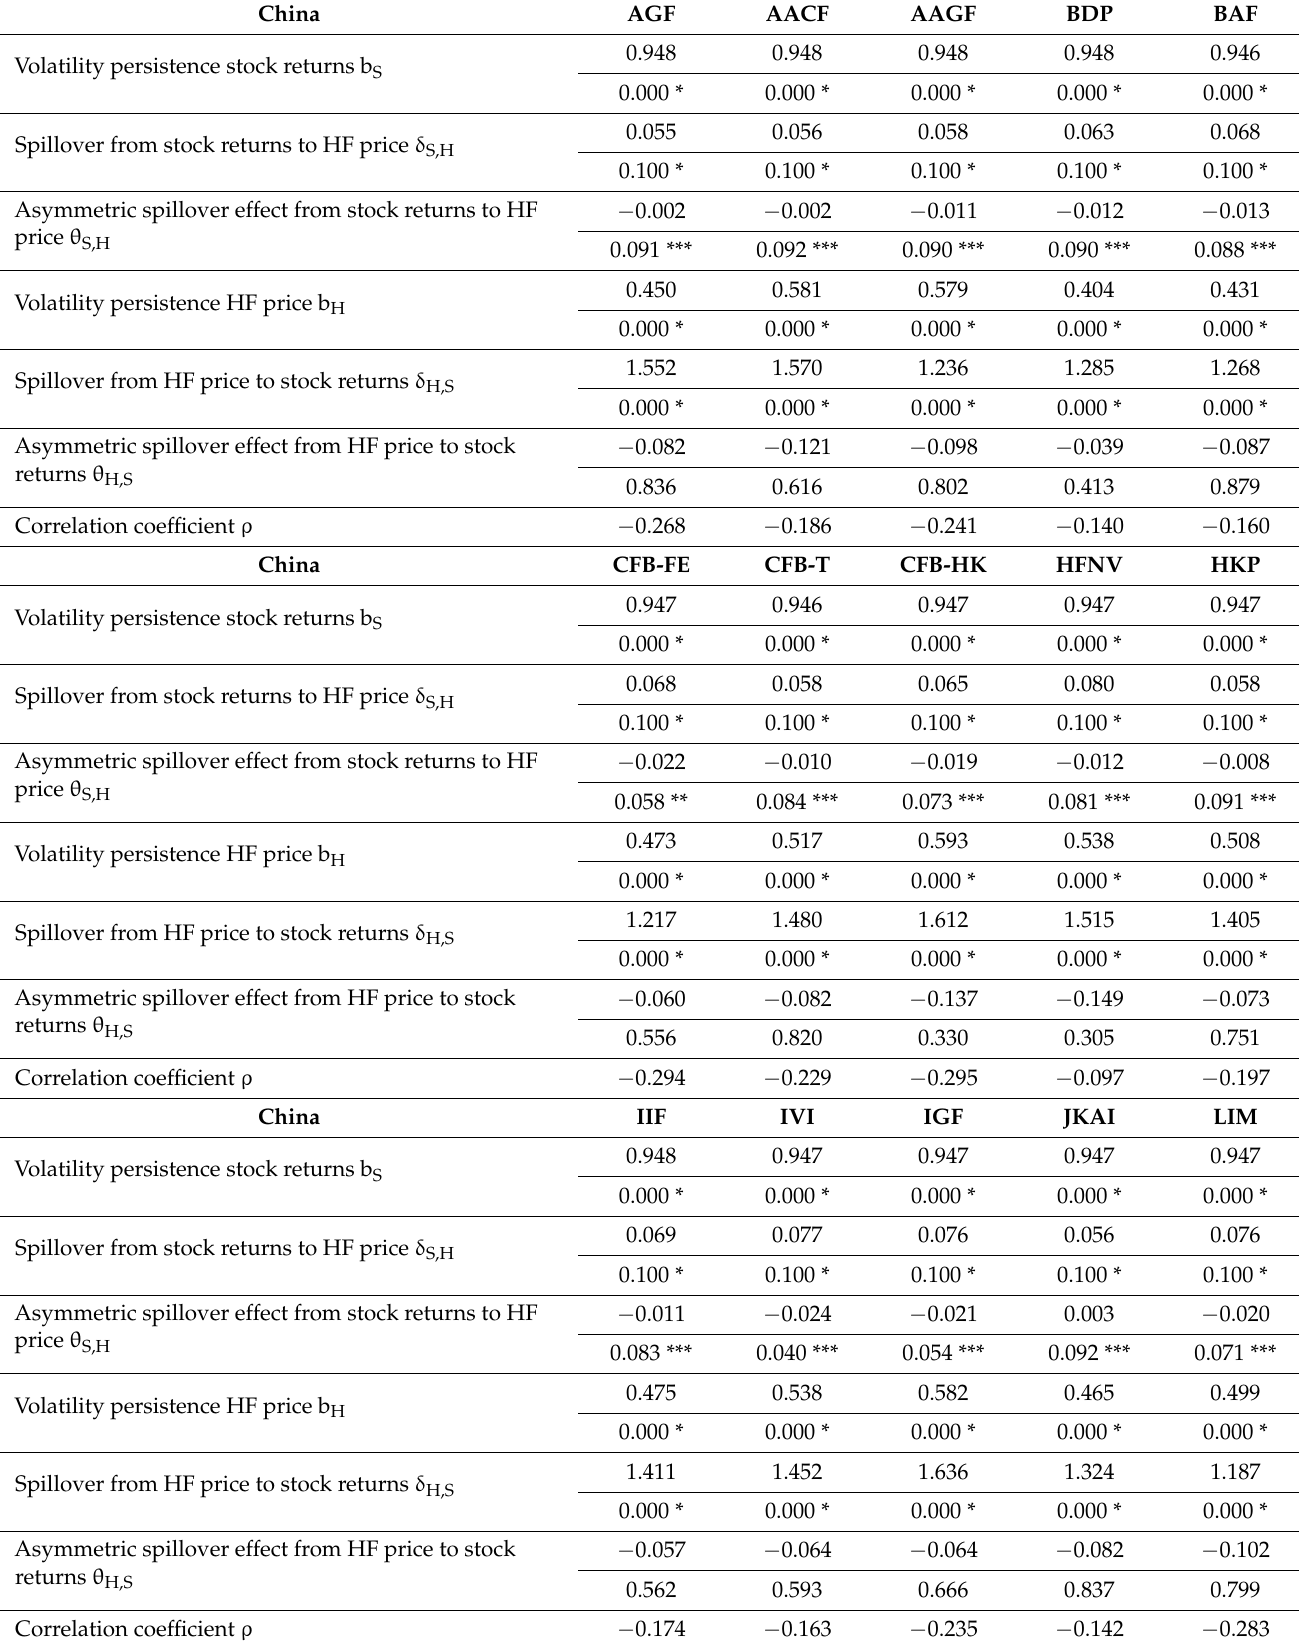
Table 8. Volatility spillover between the Chinese Stock Market (SHCOMP) and Hedge Fund